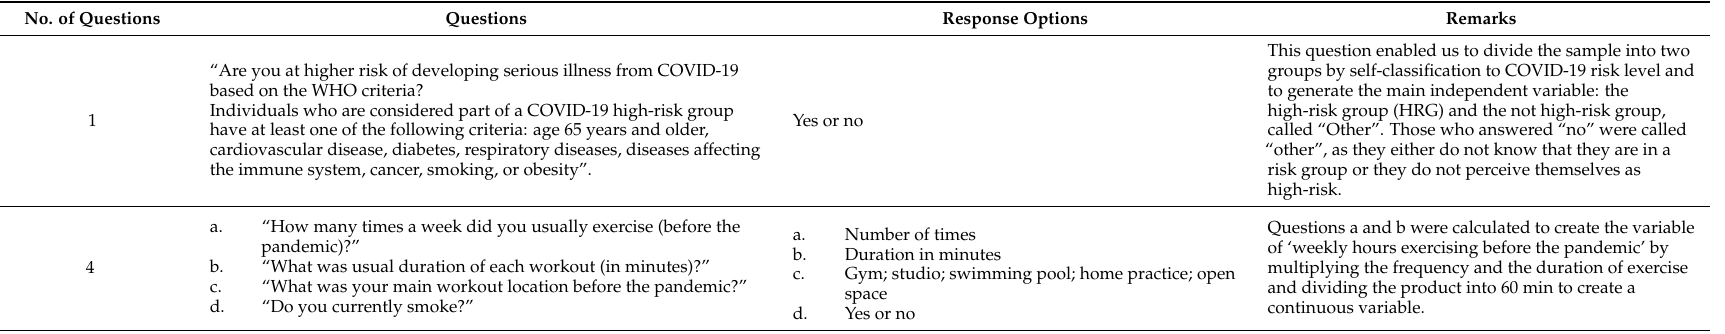
Table A1. Survey Categories, Questions, and Response